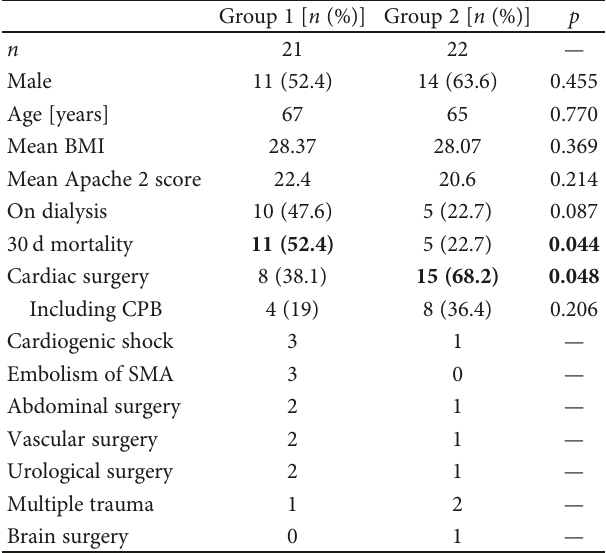
Table 1: Characteristics of 43 patients at d0 and reason for admission on